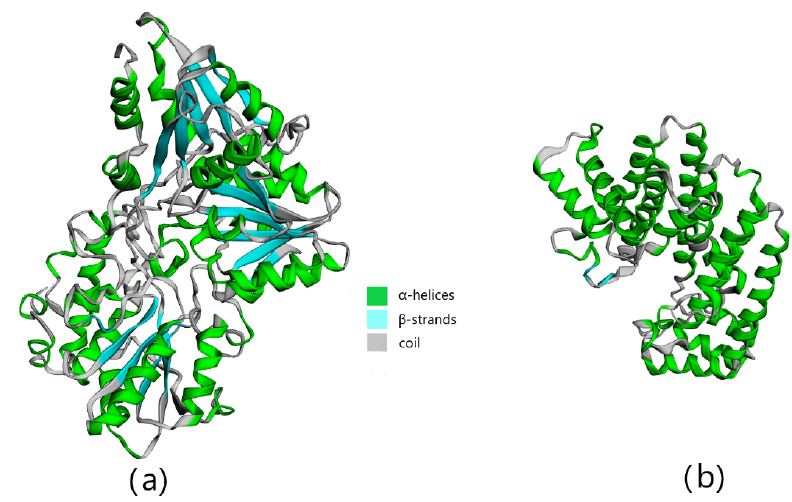
Figure 2. 3D constitution prediction of the ZbDXS ( a ) and ZbFPS ( b ) amino acid sequence.